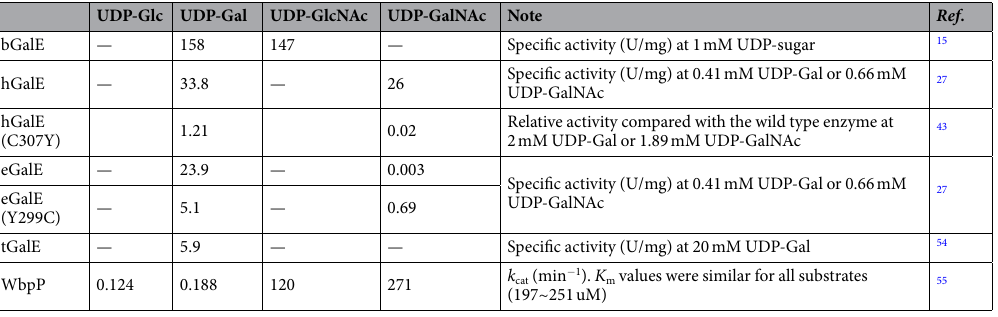
Table 1. Enzyme activities of GalE enzymes. —, Not